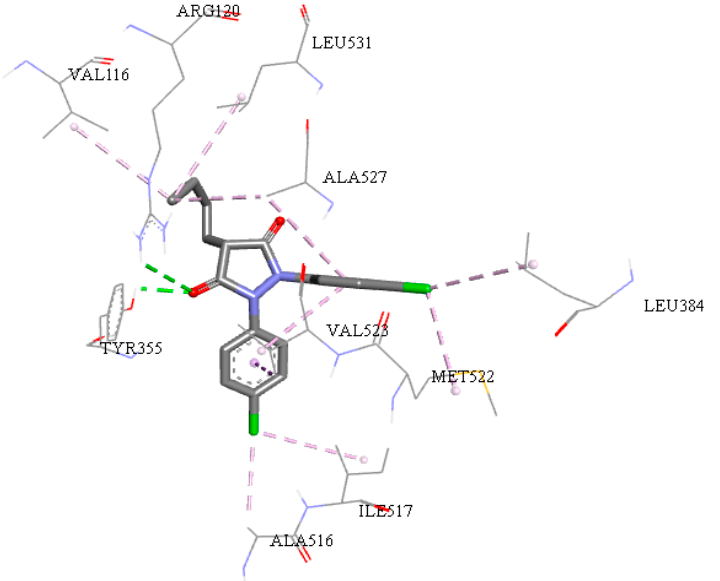
Figure 9. Interactions of structure 7 (COX-2 organism Homo sapiens ). Hydrophobic interactions alkyl, Pi-alky, Pi-sulfur, hydrogen bonds and Pi-Pi interactions can be seen.